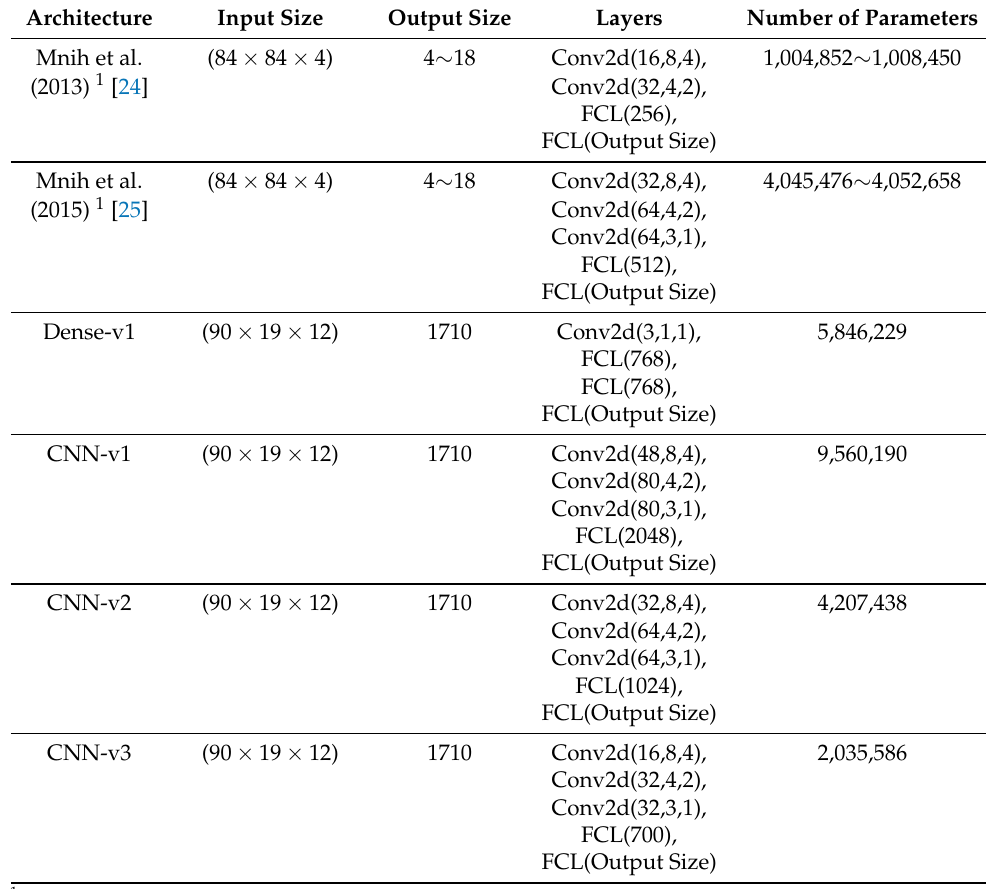
Table 4. Deep reinforcement learning neural network